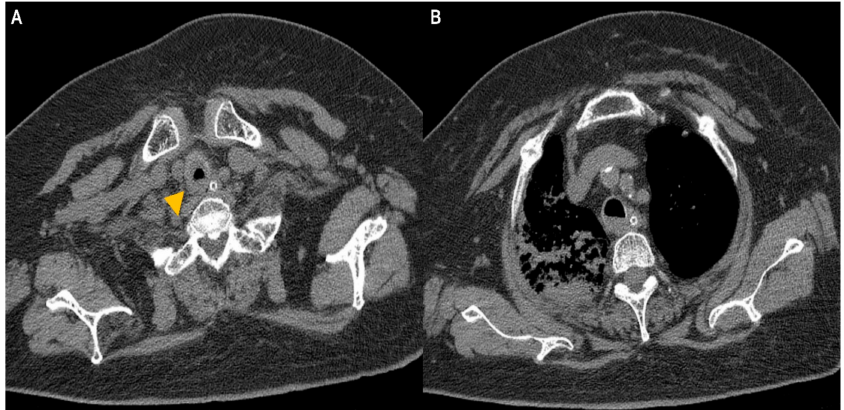
Figure 2. Chest computed tomography images. ( A , arrowhead) Aggravated diffuse wall thickening with luminal narrowing at the proximal trachea. ( B ) Peribronchial consolidation and secretion stasis in the right upper